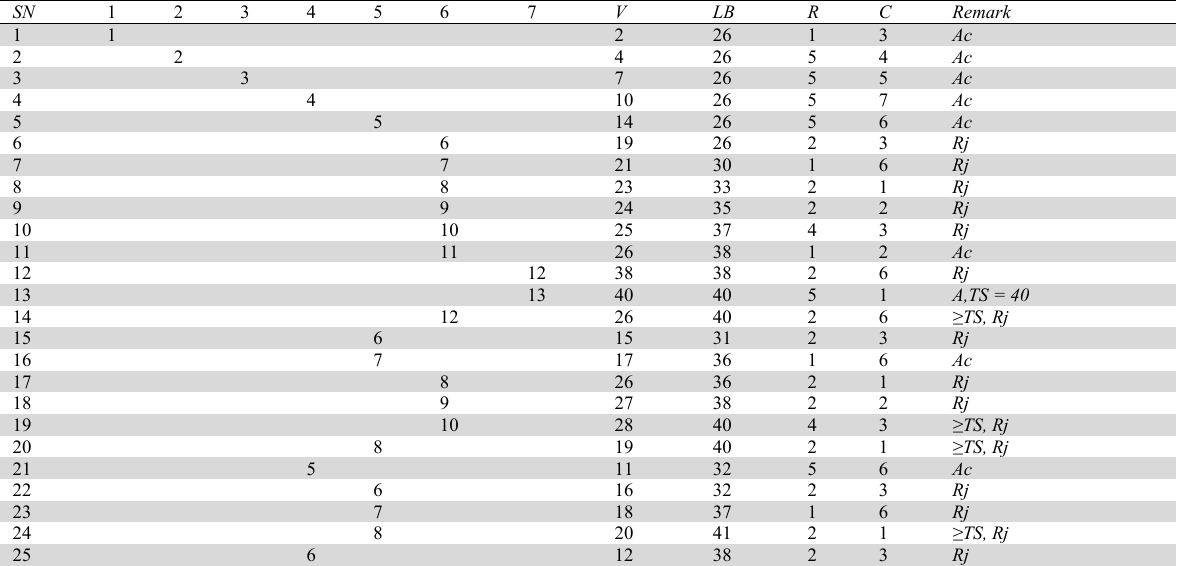
Logical flow of proposed